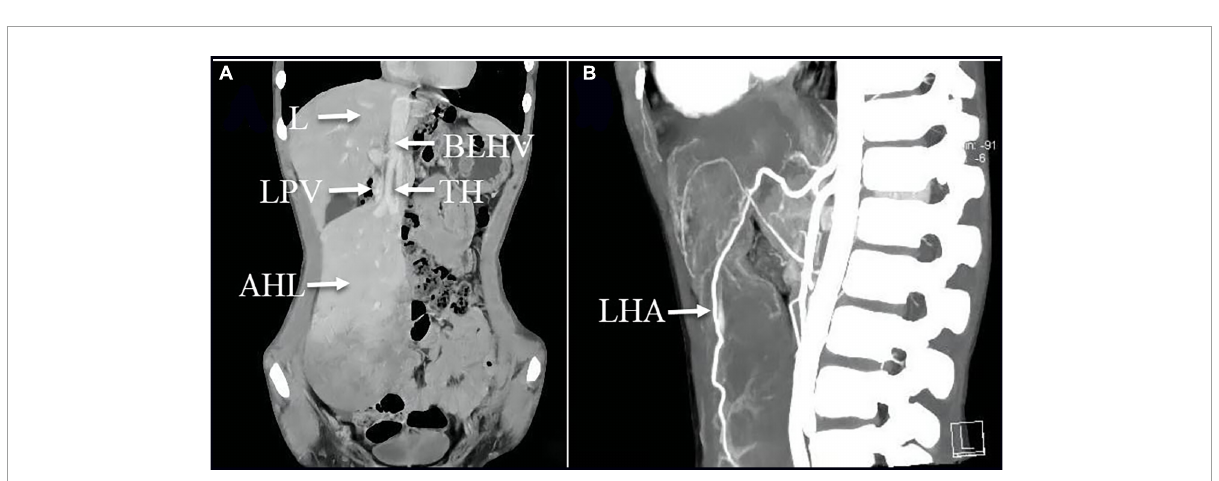
FIGURE2 (A) Coronal image of the enhanced CT scan on 27 April 2021 revealed the mass was visible as non-uniform reinforcement in the inferior portion; (A,B) CTA images illustrated that the left hepatic artery, the branch of the left hepatic vein, and the left branch of the portal vein were observed within the mass, but multiple filling defects are recognized inside the branch of the left hepatic vein. AHL, accessory hepatic lobe; TH, thrombosis; L, liver; LPV, left hepatic portal vein; BLHV, the branch of the left hepatic vein; LHA, left hepatic